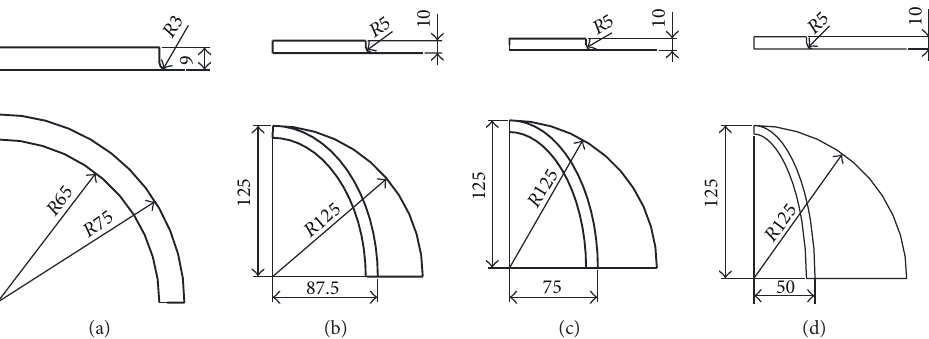
Figure 10: Blank holder used for the formability tests for MSC-MARC and Abaqus FEM commercial codes. (a) Circle. (b) 7: 10 ellipse. (c) 6 :10 ellipse. (d) 4: 10